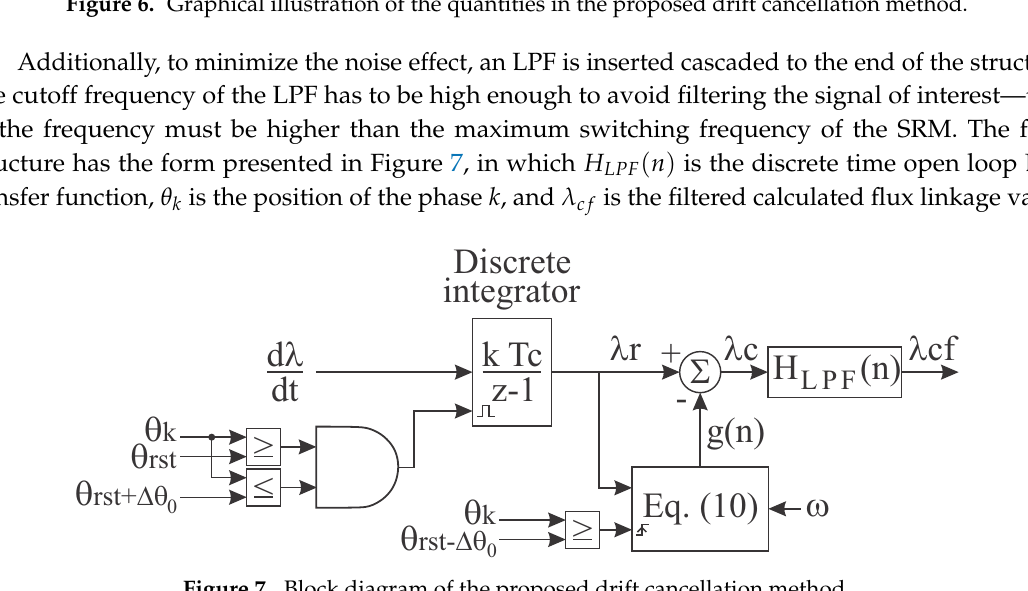
Figure 7. Block diagram of the proposed drift cancellation